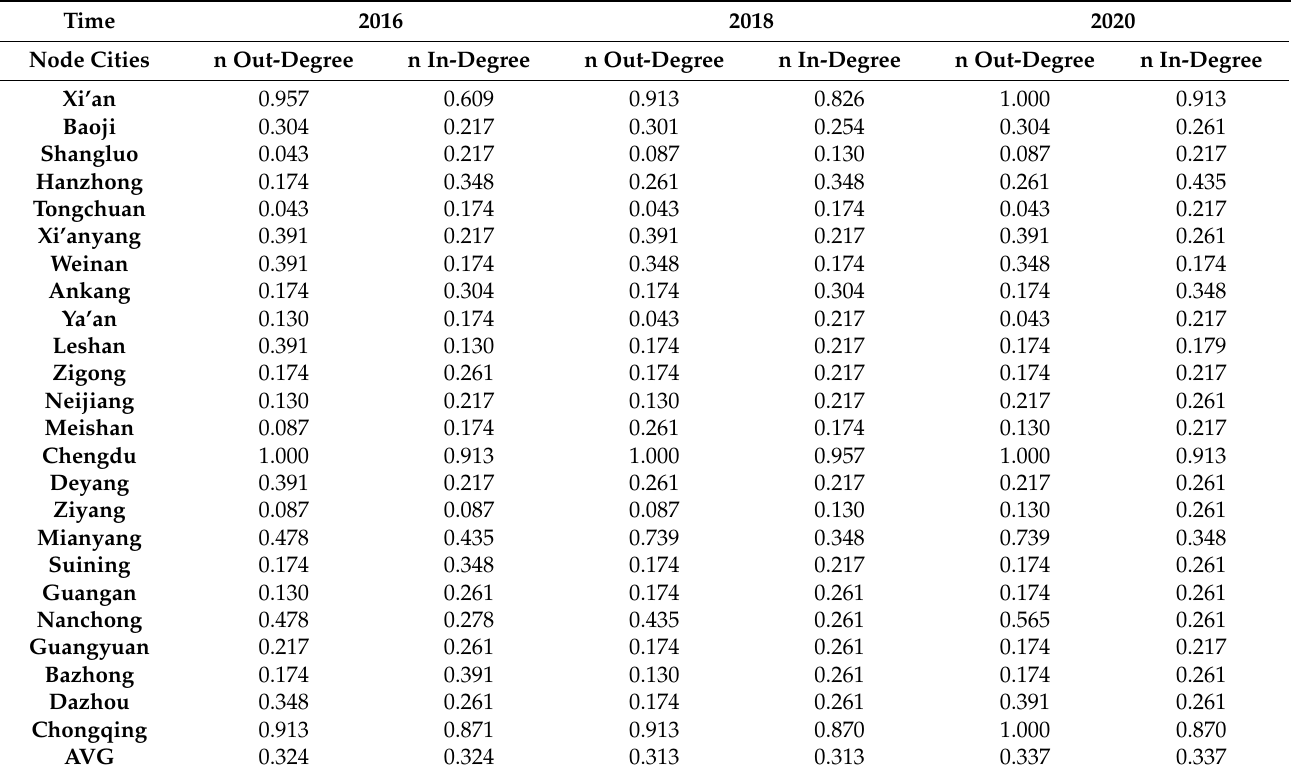
Table 1. In- and out-degrees of cultural tourism Internet attention of WTEZ in 2016, 2018, and 2020.